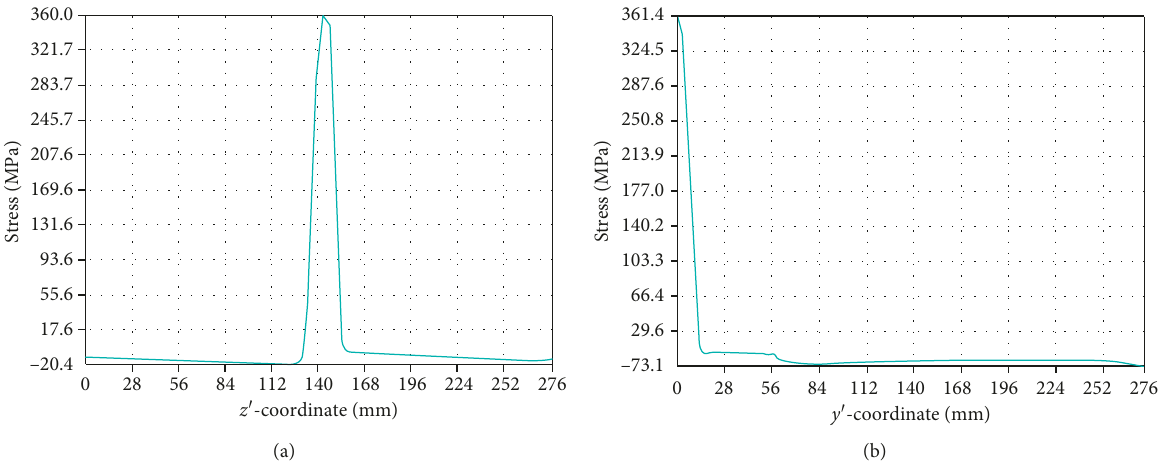
Figure 15: The residual stress distribution at 1/2 section of the U-rib and top deck. (a) The longitudinal residual stress of the top deck. (b) The longitudinal residual stress of the